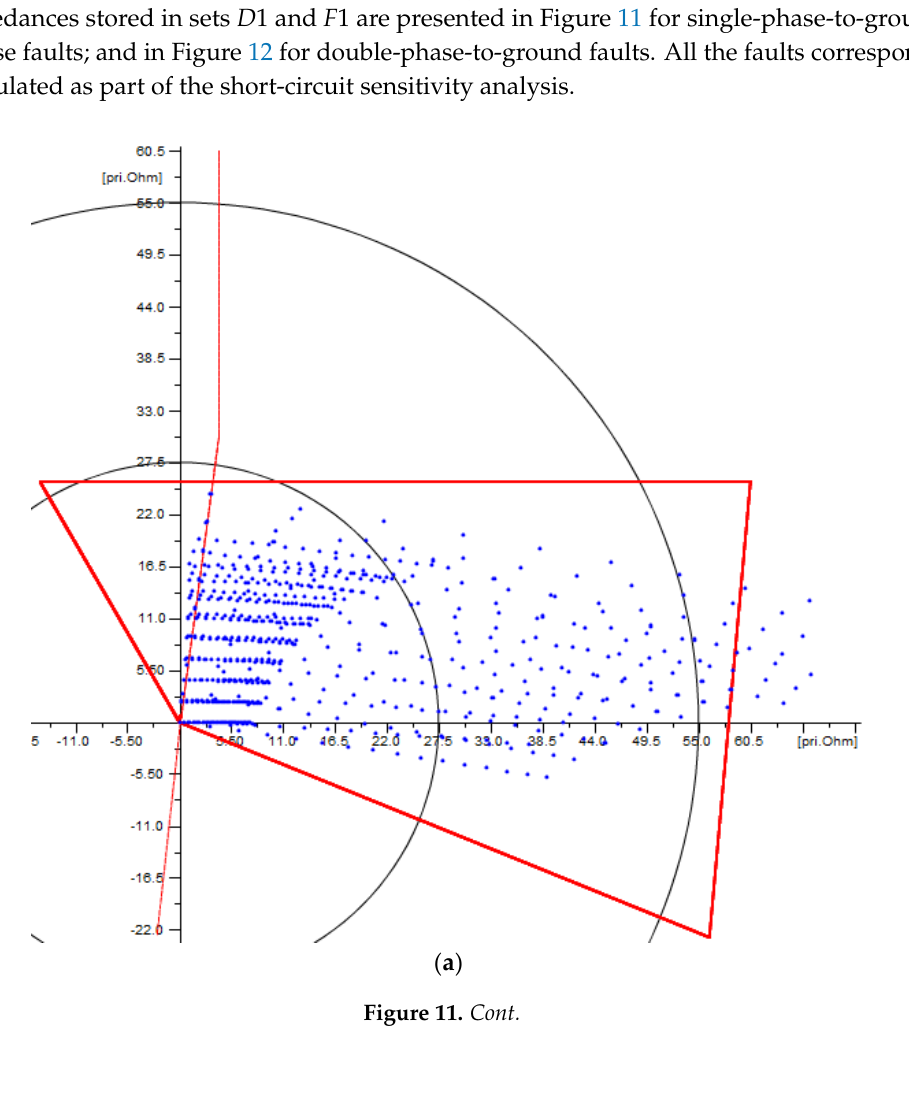
Table 2. Initial zone 1 reach settings.